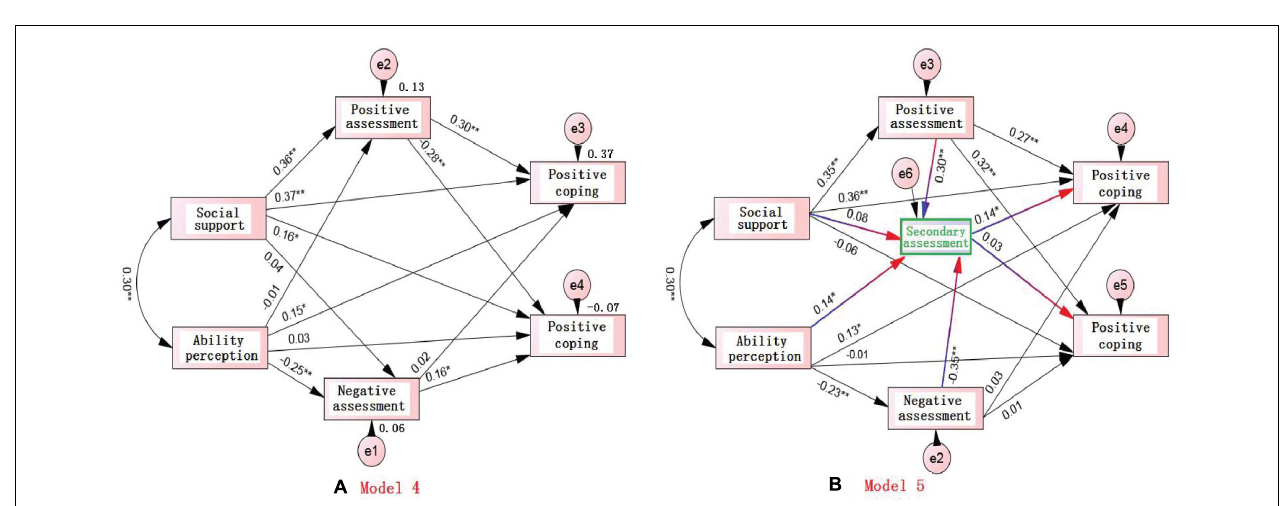
FIGURE 2 | Effects of social support, ability perception, and primary assessment on competition coping strategies: (A) : Model 4: Direct effects of social support, ability perception, and primary assessment on competition coping strategies; (B) Model 5 Effects of social support, ability perception, and primary assessment on competition coping strategies via mediating role of secondary assessment.